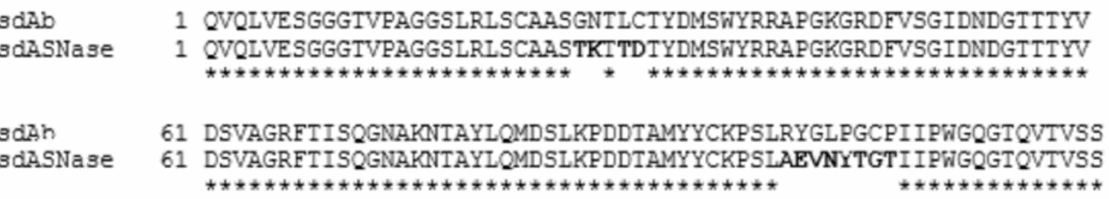
Figure 1. Amino acids transplanted from EcAII onto sdASNase. Top line: EcAII residue numbering; bottom line: sdASNase residue numbering. In red, residues of EcAII catalytic triads.